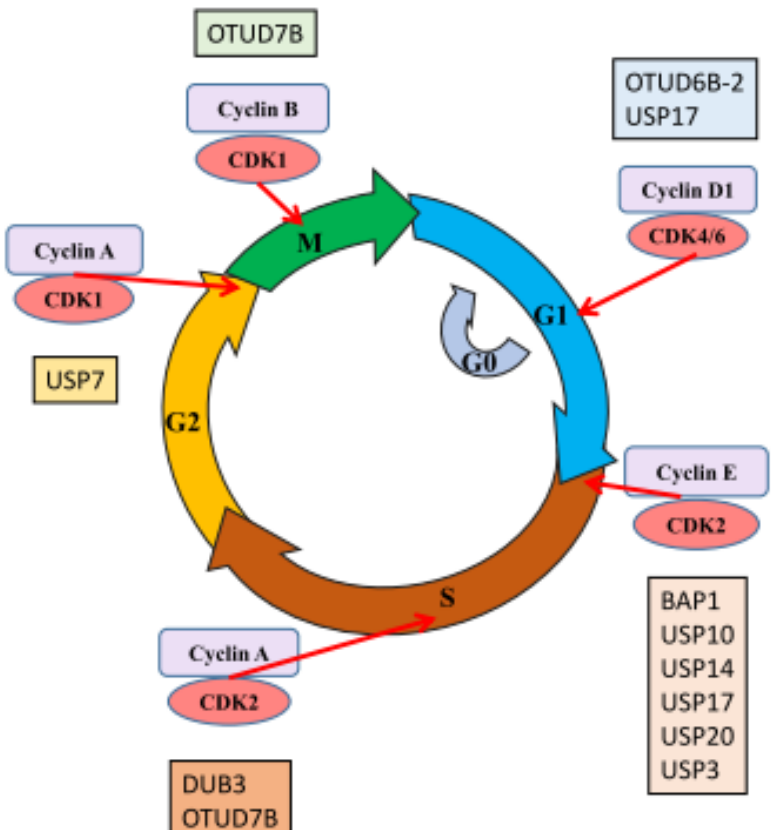
Figure 1. Roles of DUBs in cell cycle control in cancers. The eukaryotic cell cycle consists of the G1 phase (blue), the S-phase (brown), the G2 phase (yellow), and the M (mitosis) phase (green). Cells can enter a quiescent state, the G0 phase (grey). Cell cycle phases are indicated by different colored arrows. The cell cycle is regulated by complexes that are composed of cyclins (light purple), and its relative cyclin-dependent protein kinases (CDKs) (pink). The cyclin-CDK complex plays regulatory roles in the cell cycle. The red arrows indicate their targets, either within the designated cell cycle phase or in the transition state. Various DUBs have been shown to interact with the cyclin–cdk complex. DUBs that participate in G1 phase are labeled in light blue; S phase in light brown; G2 phase in light yellow; and M phase in light green. The detailed interaction partner of each individual DUB can be found in the main text and the Table 2.